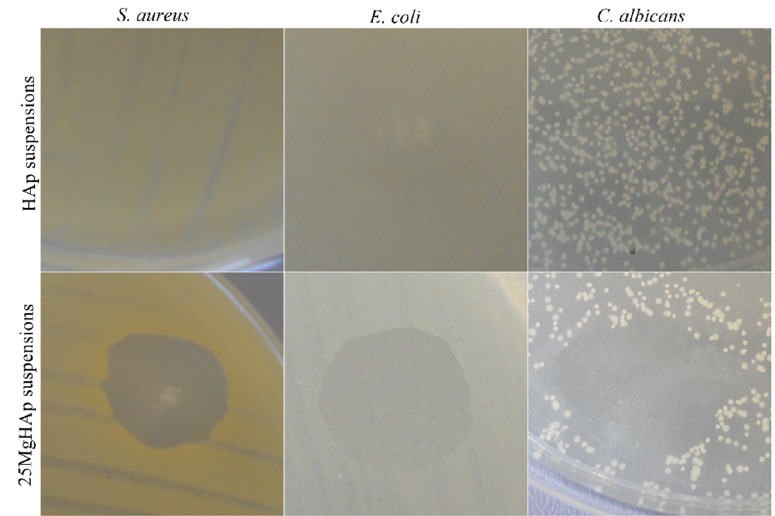
Figure 16. Antimicrobial qualitative assay of HAp and 25MgHAP suspensions against Staphylococcus aureus ATCC 25923, Escherichia coli ATCC 25922, and Candida albicans ATCC 90029.